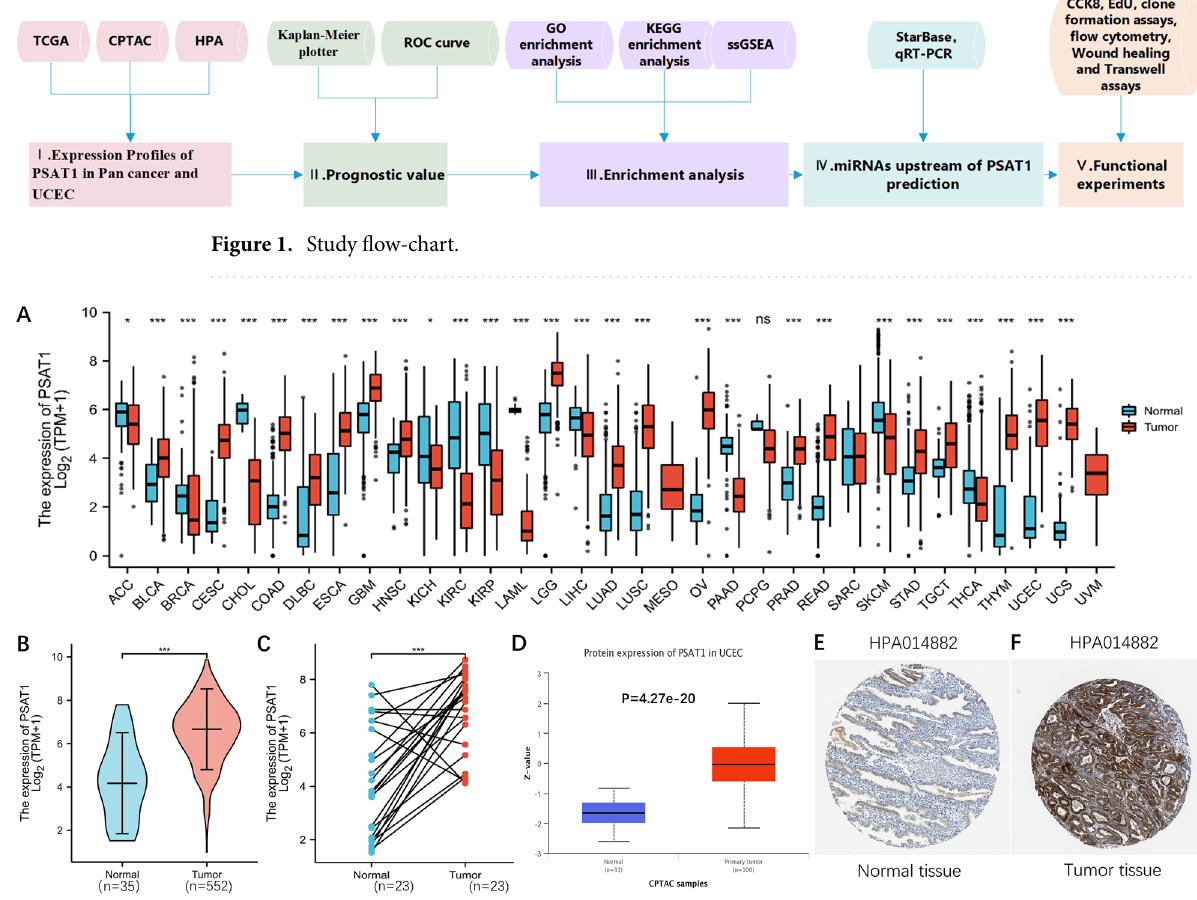
Figure 2. Expression Profiles of PSAT1 in Pan cancer and UCEC. ( A ) PSAT1 expression levels in Pan cancer and matched normal tissues. ( B ) PSAT1 expression levels in UCEC and normal endometrial tissues. ( C ) PSAT1 expression levels in UCEC and paired normal endometrial tissues. ( D ) The protein expression levels of PSAT1 in UCEC and normal endometrial tissues based on CPTAC database. Immunohistochemical results of PSAT1 in normal endometrial tissues ( E ) and UCEC tissues ( F ) from the HPA database. *p < 0.05, ***p < 0.001, ns, P >